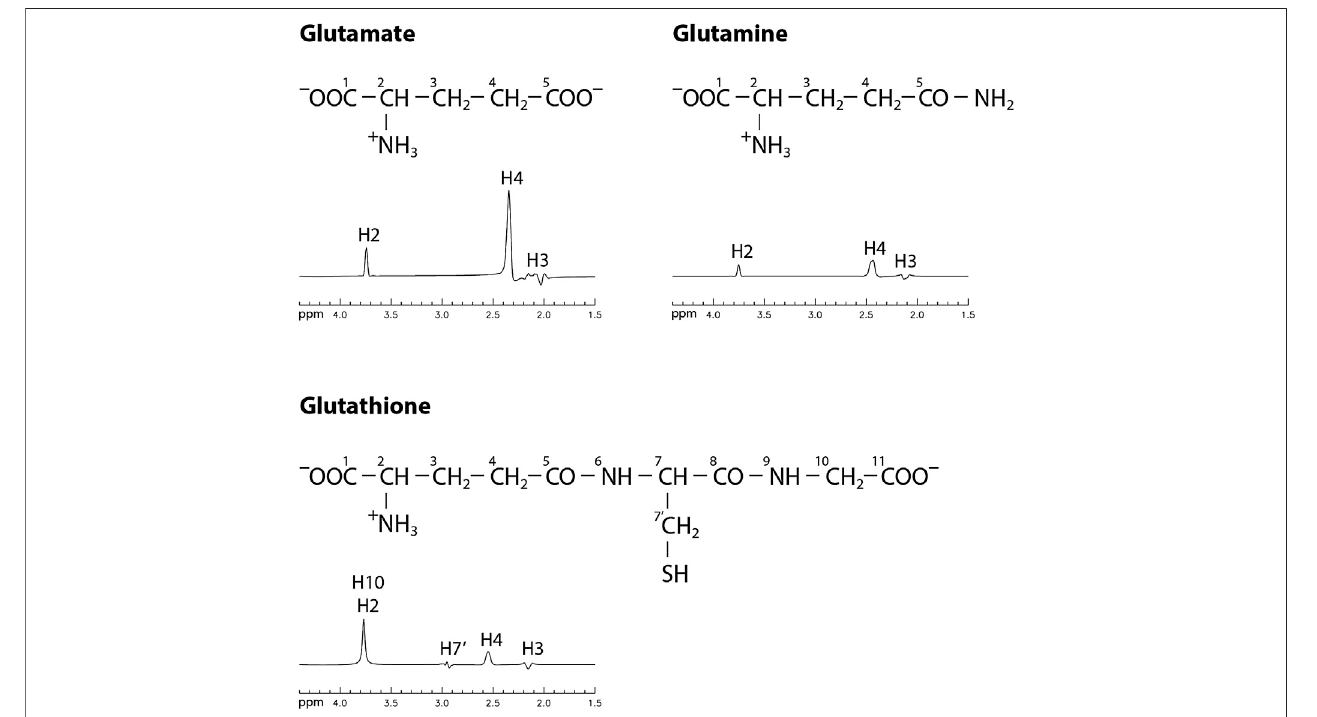
FIGURE 1 | Chemical structures and numerically computed spectra of Glu, Gln, and GSH in the range of 1.5 – 4.4 ppm with TE/TE 1 = 106/16 ms. Concentration ratios of [Glu]: [Gln]: [GSH] = 10: 3: 2 were used to scale the spectra.